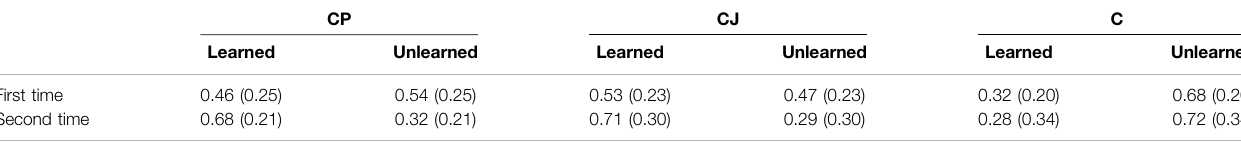
CP,Chinesewordandpicturepairs;CJ,ChinesewordandJapanesewordpairs;C,Chinesewordsonly;theseratesshowmissratesaslearnedorunlearnedrates(standarddeviations), witheach numberoflearnedorunlearneditems dividedbytherespective sumoflearnedandunlearneditems.Thesemeanratesand standarddeviationsassociatewith